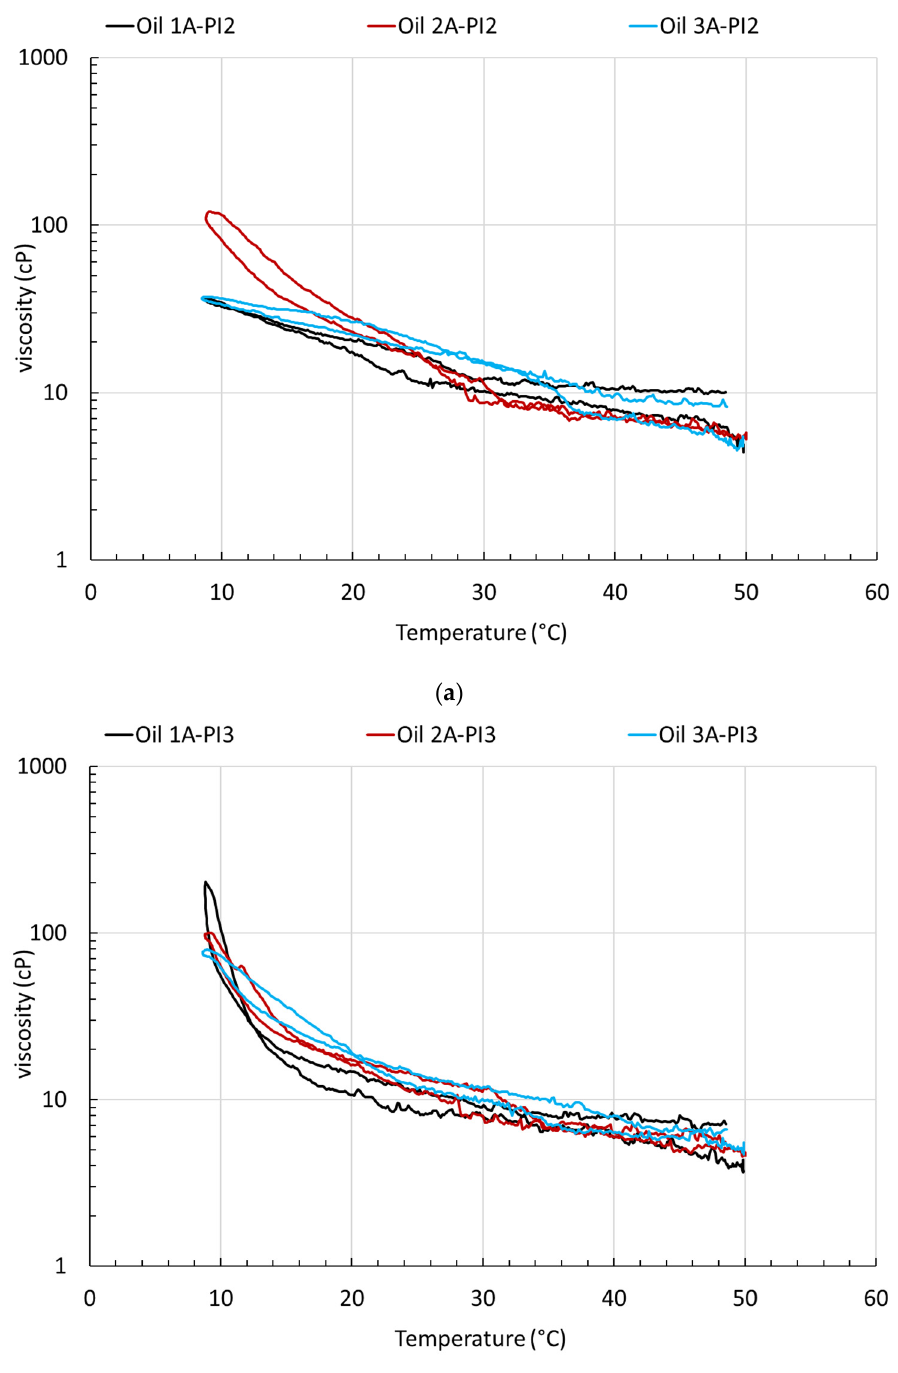
Figure 9. Viscosity as a function of the cooling/heating cycle 50 °C → 8 °C → 50 °C for oils ( a ) 1A-PI2, 2A-PI2, and 3A-PI2 and ( b ) 1A-PI3, 2A-PI3, and 3A-PI3, measured by applying a constant shear of 25 s − 1 and a cooling/heating rate of 1 °C/min.